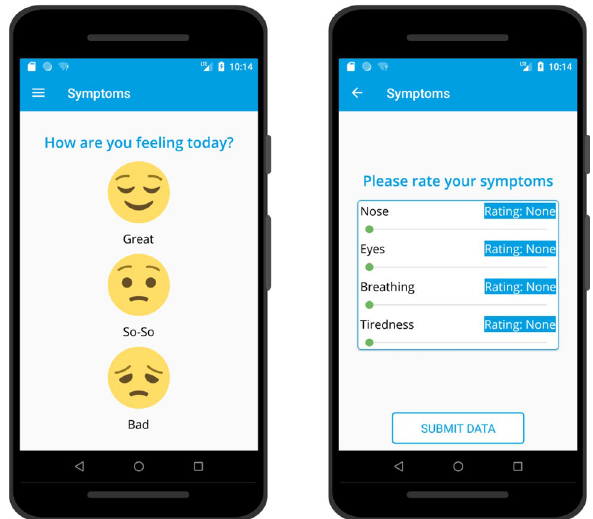
Figure 1. The BritainBreathing web application example